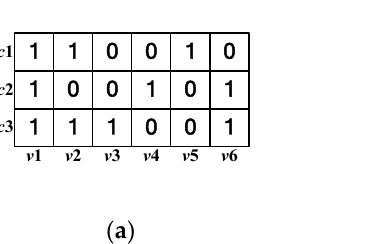
Figure 1. Example of ( a ) H matrix mapping to the ( b ) Tanner graph.